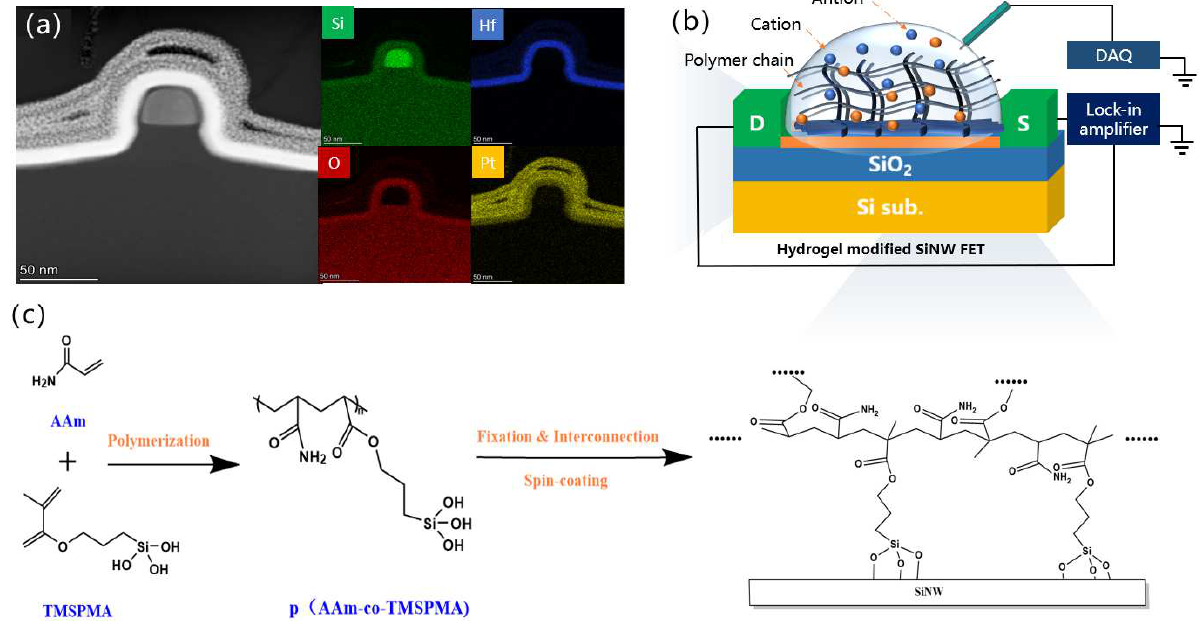
Figure 1. ( a ) TEM image of Si NW channel of the device, the right: EDS elemental mappings of O, Si, Hf and Pt, respectively. ( b ) Schematic test of hydrogel-modified SiNW FET surface. ( c ) Strategy for the modification of the gate, including polymerizing acrylamide to form p(AAm-co-TMSPMA), spin-coating and curing of hydrogels onto FET surfaces.